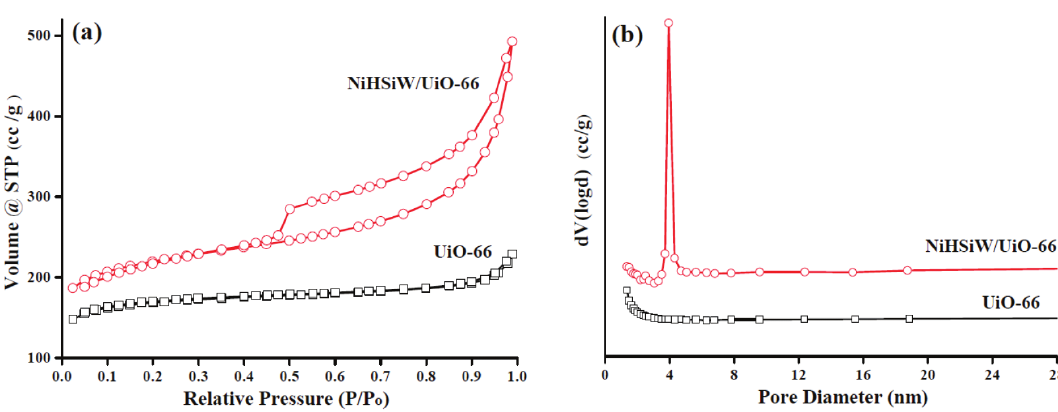
Figure 1: (a) FT-IR spectra in the region from 2000 to 450 cm −1 with H UiO-66, NiHSiW and NiHSiW/UiO-66 samples.